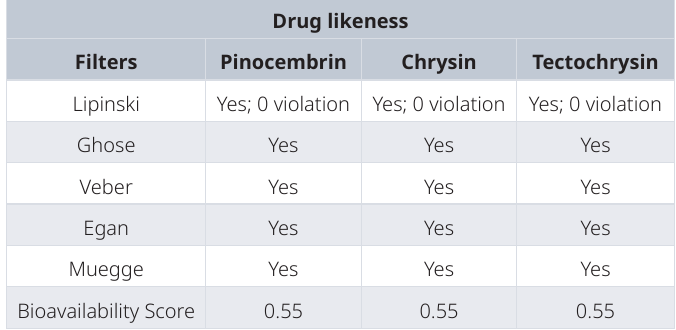
Table 4. Drug likeliness prediction of the ligands using